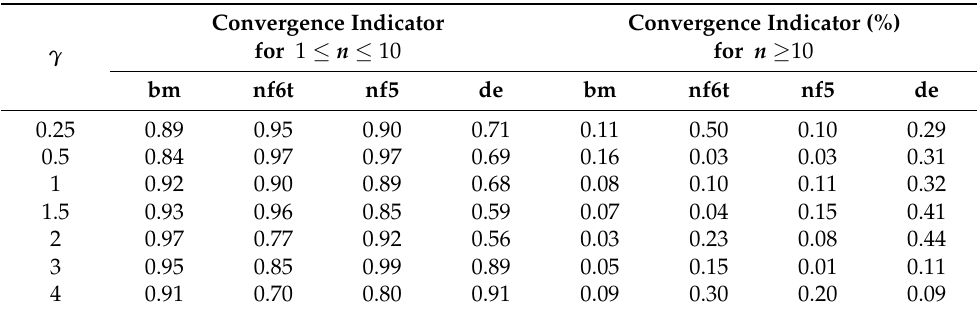
Table 4. Convergence indicator of the bm , de , nf5 , and nf6t relaxation schemes with partition size variation.